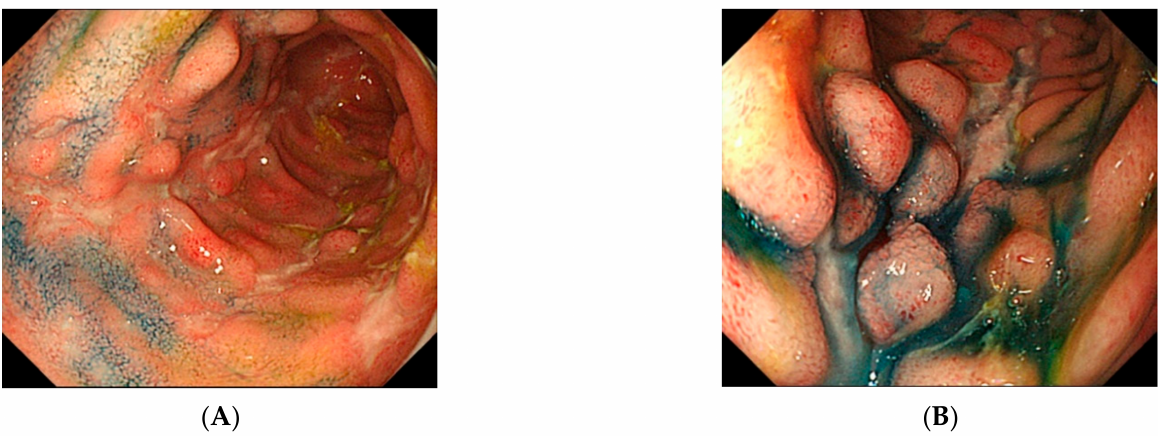
Figure 1. Enteroscopic findings with indigo carmine dye-sprayed images. Longitudinal ulcer ( A ) and cobblestone appear- ance ( B